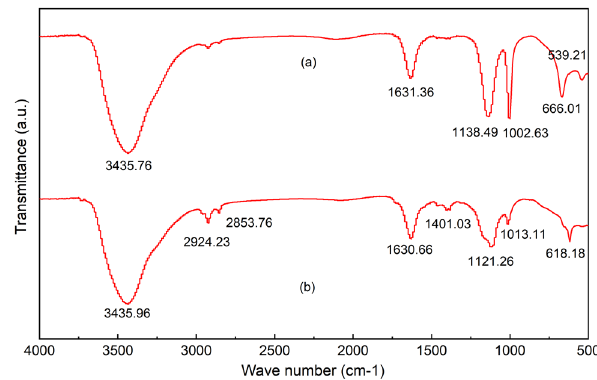
Figure 5: FTIR spectra of CdS – Ag 2 S nanocomposite: ( a ) before photocatalysis; ( b ) after